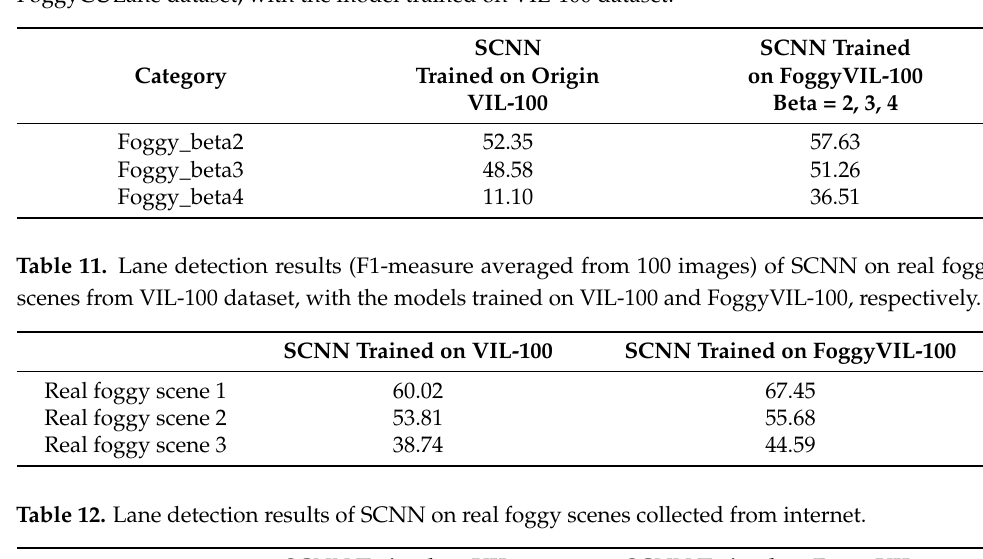
Table 10. Lane detection results (F1-measure) of SCNN tested on simulated foggy scenes from FoggyCULane dataset, with the model trained on VIL-100 dataset.